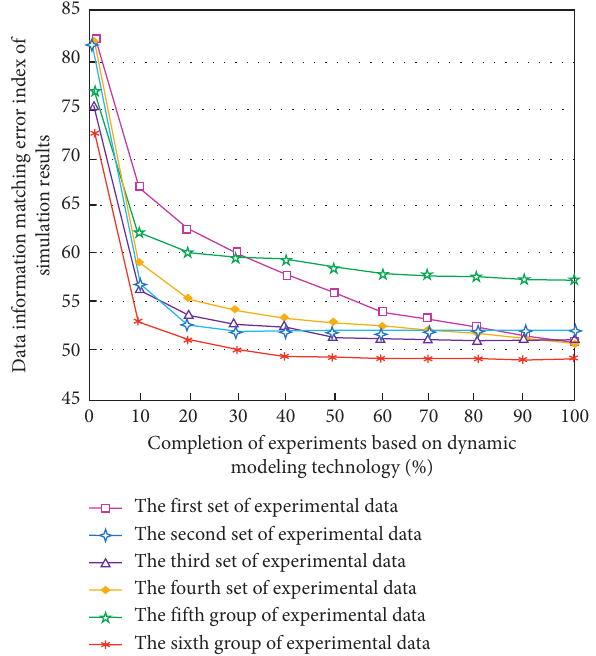
Figure 6: Preliminary experimental results of the value evaluation model before the improvement on 6 sets of experimental data.